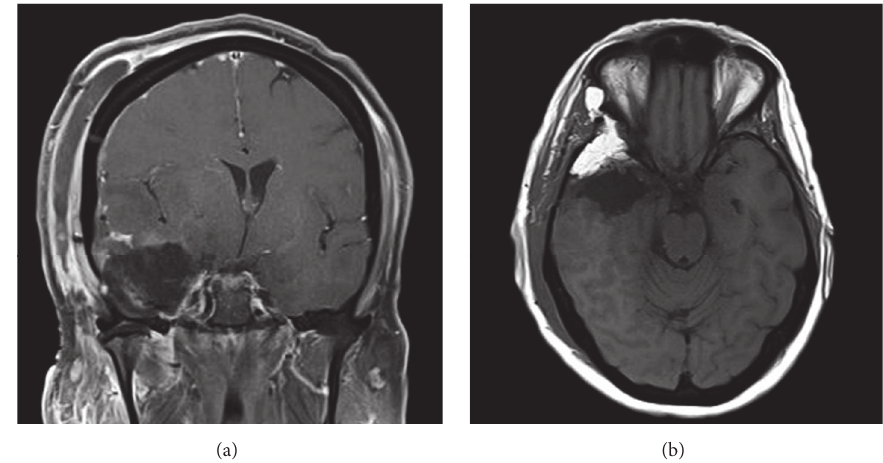
Figure 3: Postoperative T1-weighted gadolinium-enhanced MRI of the brain. Both (a) coronal and (b) axial sequences confirm gross total resection of all enhancing tumor. New hyperintensity appreciated at the anterior right temporal pole identifies abdominal fat graft placed during